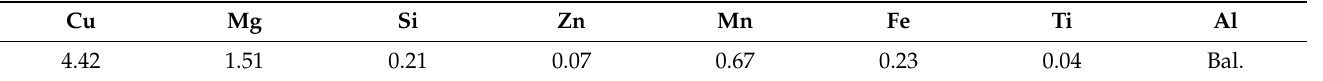
Table 1. Chemical composition of the 2A12 alloy (mass fraction, %).